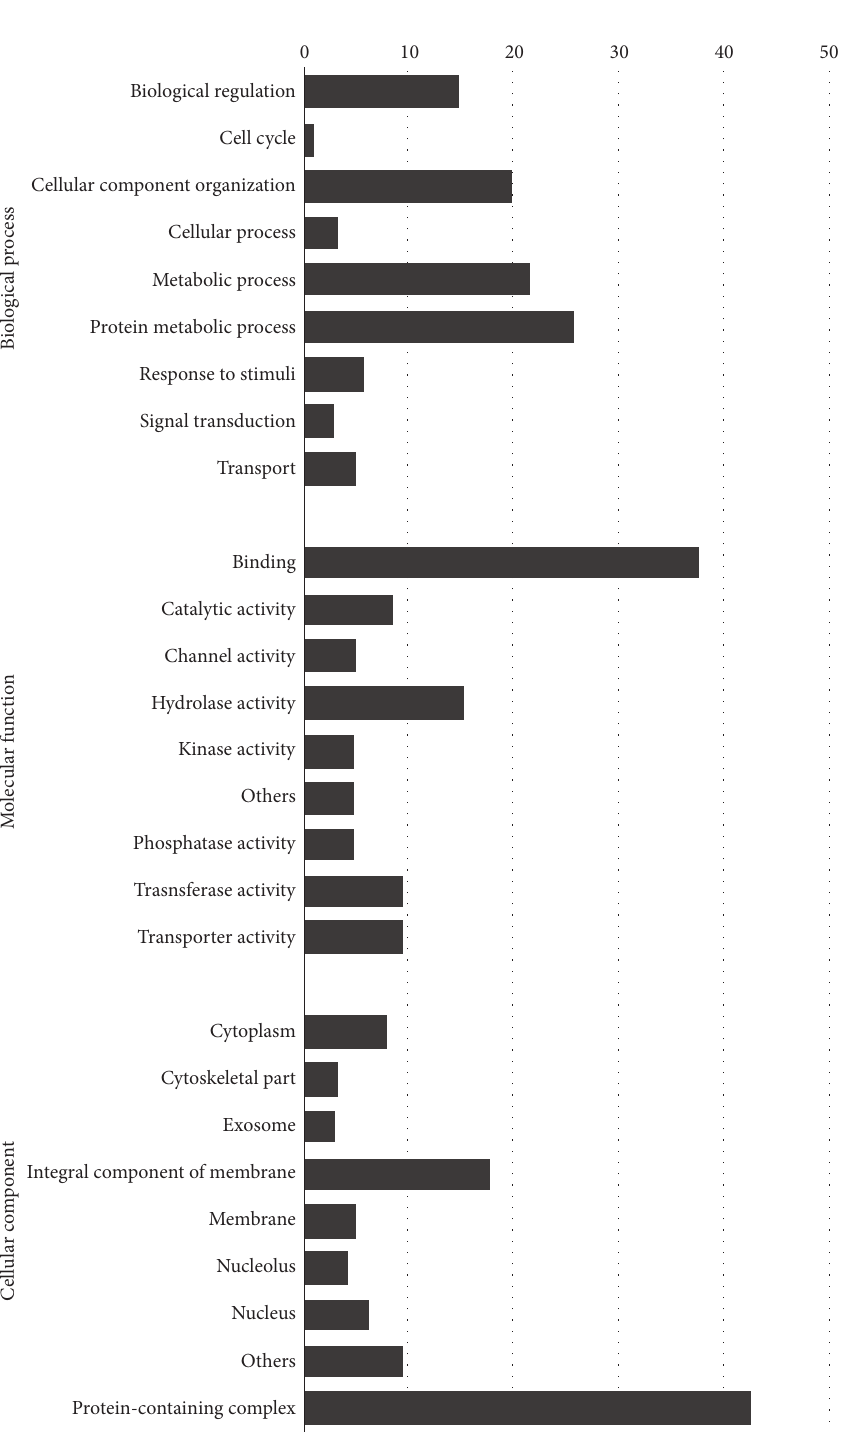
Figure 4: Percentage representation of GO enrichment analysis of lncRNA targets in S. haematobium